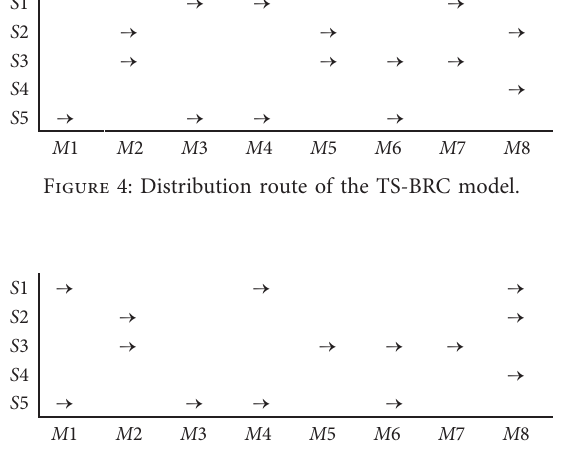
Figure 5: Distribution route of the TS-ERC model.